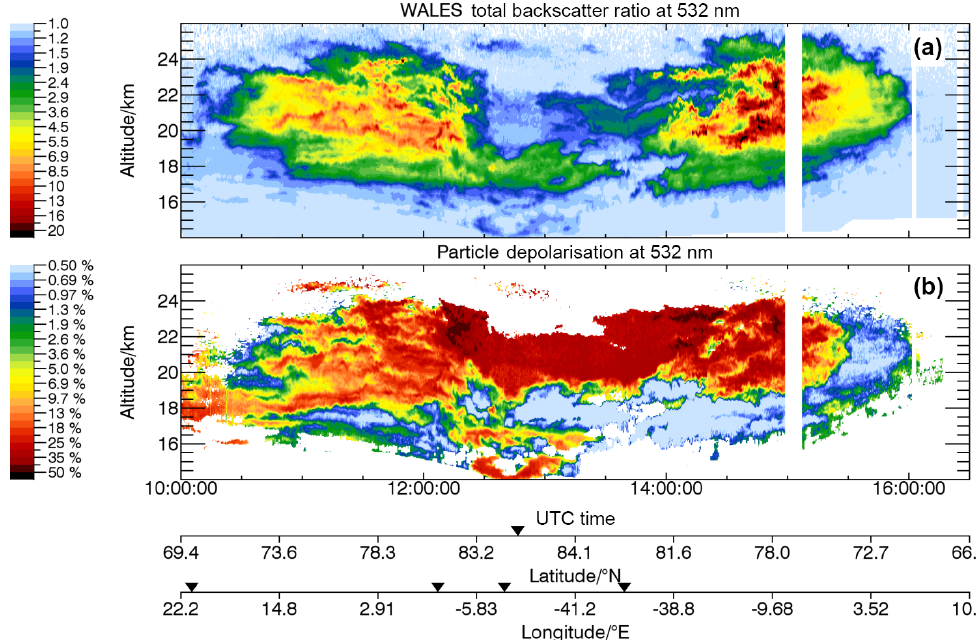
Figure 3. Lidar observation of a synoptic-scale polar stratospheric cloud observed on 22 January 2016. (a) Backscatter ratios from the WALES lidar (Wirth et al., 2009) at 532nm wavelengths during a HALO flight into the Arctic vortex and (b) particle depolarization. The time of the flight as well as latitude and longitude of the HALO flight path are indicated. Turning points of the HALO are marked by triangles.